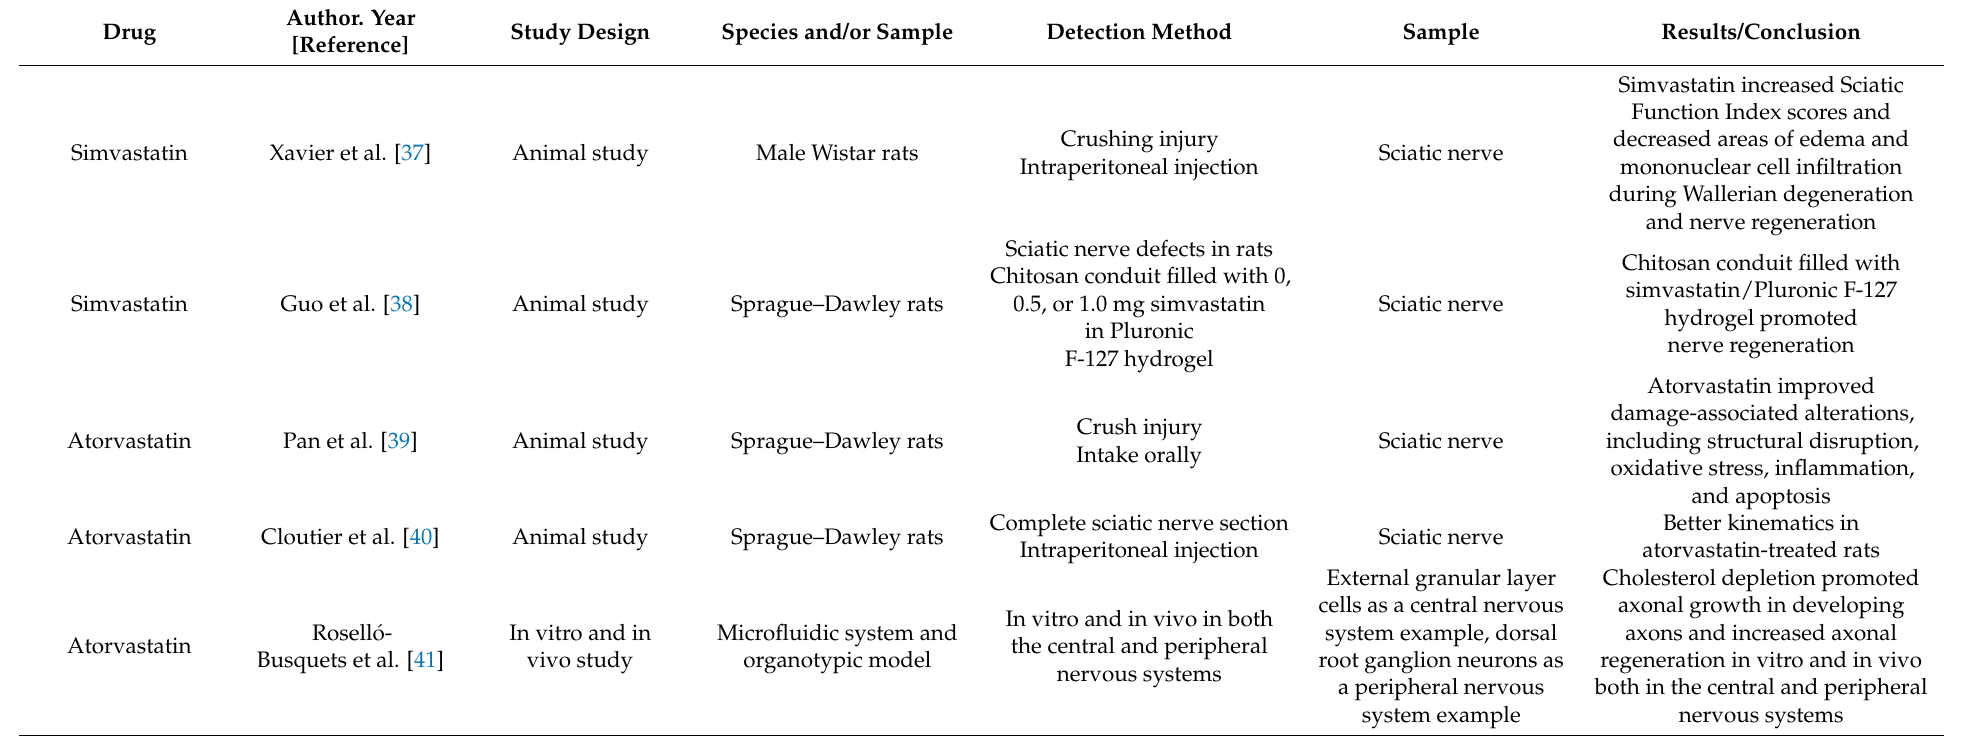
Table 3. Summary of studies assessing the use of statins for the treatment of peripheral nerve